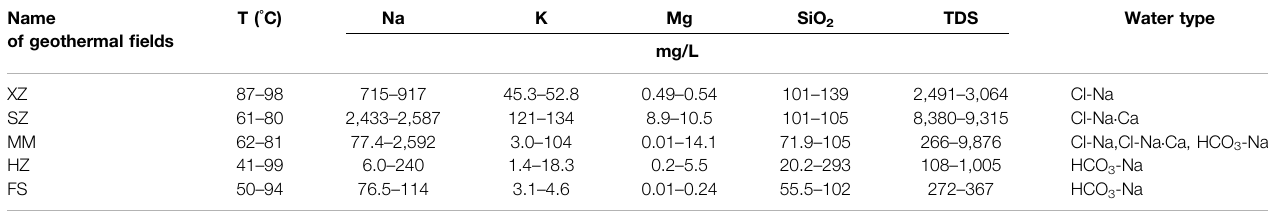
TABLE 3 | Hydrogeochemical properties of geothermal water from typical geothermal fi elds. Name of geothermal fi elds